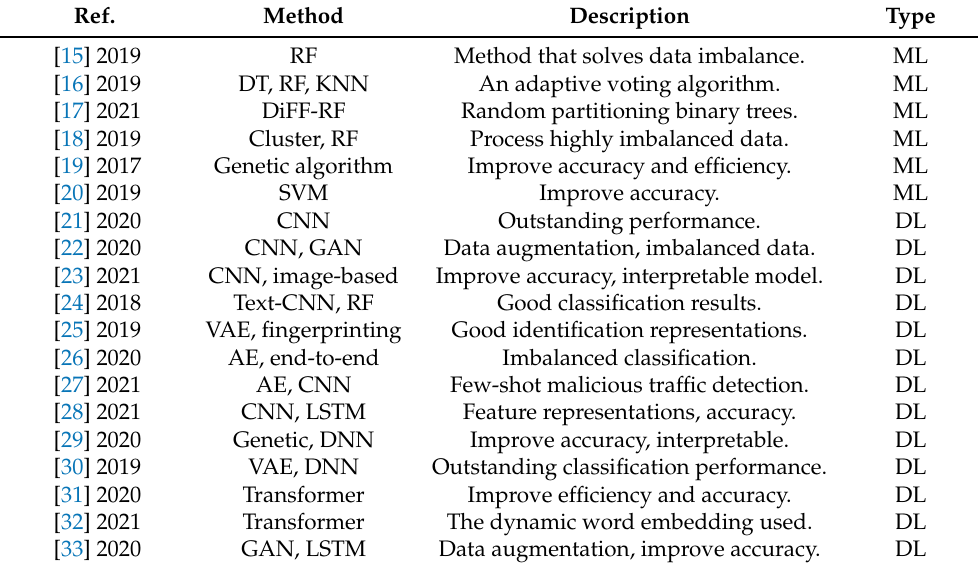
Table 1. Some related methods in the past three years. Ref. Method Description Type [15] 2019 Method that solves data imbalance. ML An adaptive voting algorithm.